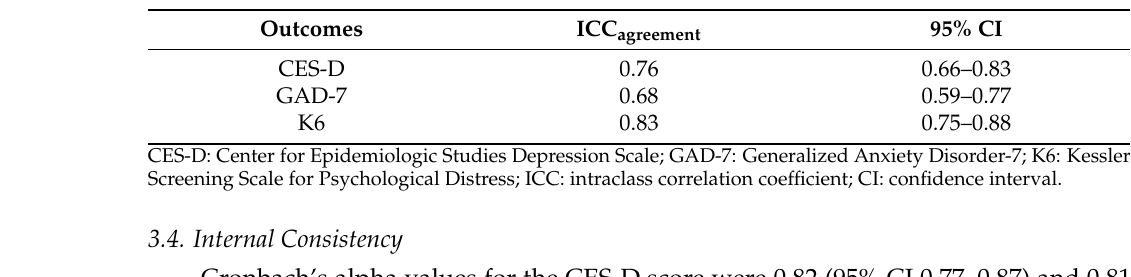
Table 3. Intragroup ICC (95% CI) for the CES-D, GAD-7, and K6.